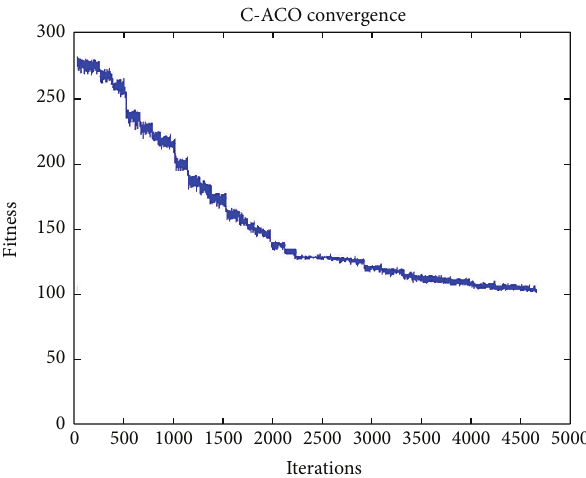
Figure 8: Number of iterations required for C-ACO to